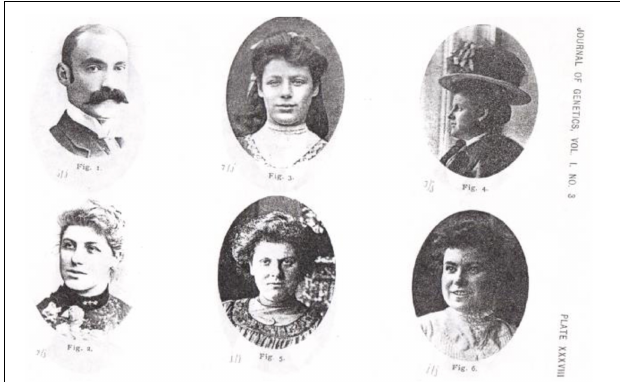
FIGURE 2 | A Jew (1) married to the daughter of Jew and Gentile (2) who gave birth to “Non-Jewish looking daughters,” (3, 4) and “Jewish looking children” (5, 6) (Salaman,